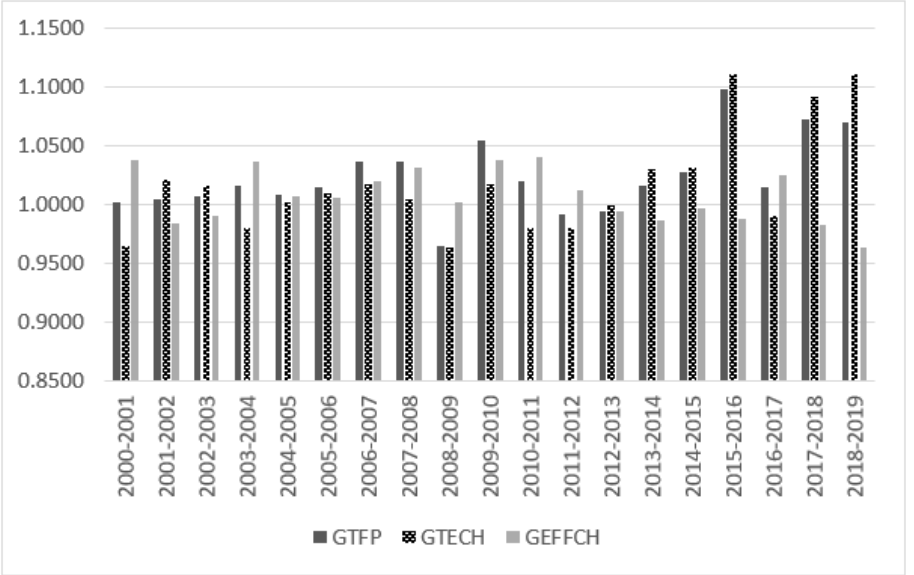
Figure 1. GTFP and its decomposition based on human capital composition.